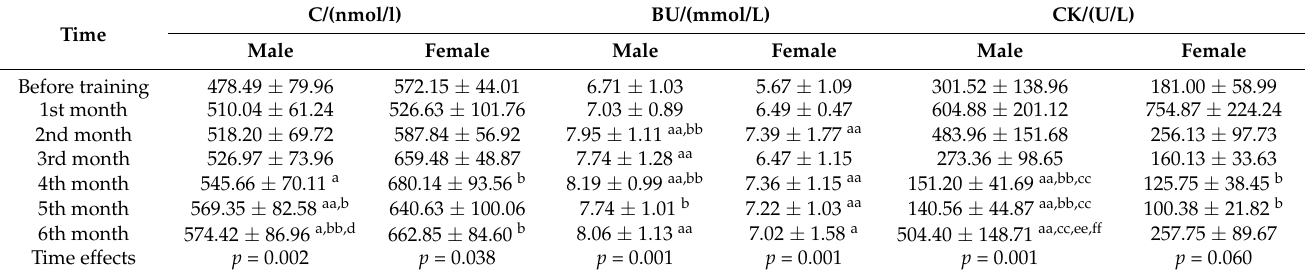
Figure 2. Graph showing the results of leukocyte and red blood cell-related indicators in the blood of athletes: ( a ) Changes of WBC in blood at different times; ( b ) Changes of RBC in blood at different Table 6. The results of changes in C, BU, and CK in the blood of athletes. times; ( c ) Changes of Hb in blood at different times. Data are mean ± SD.